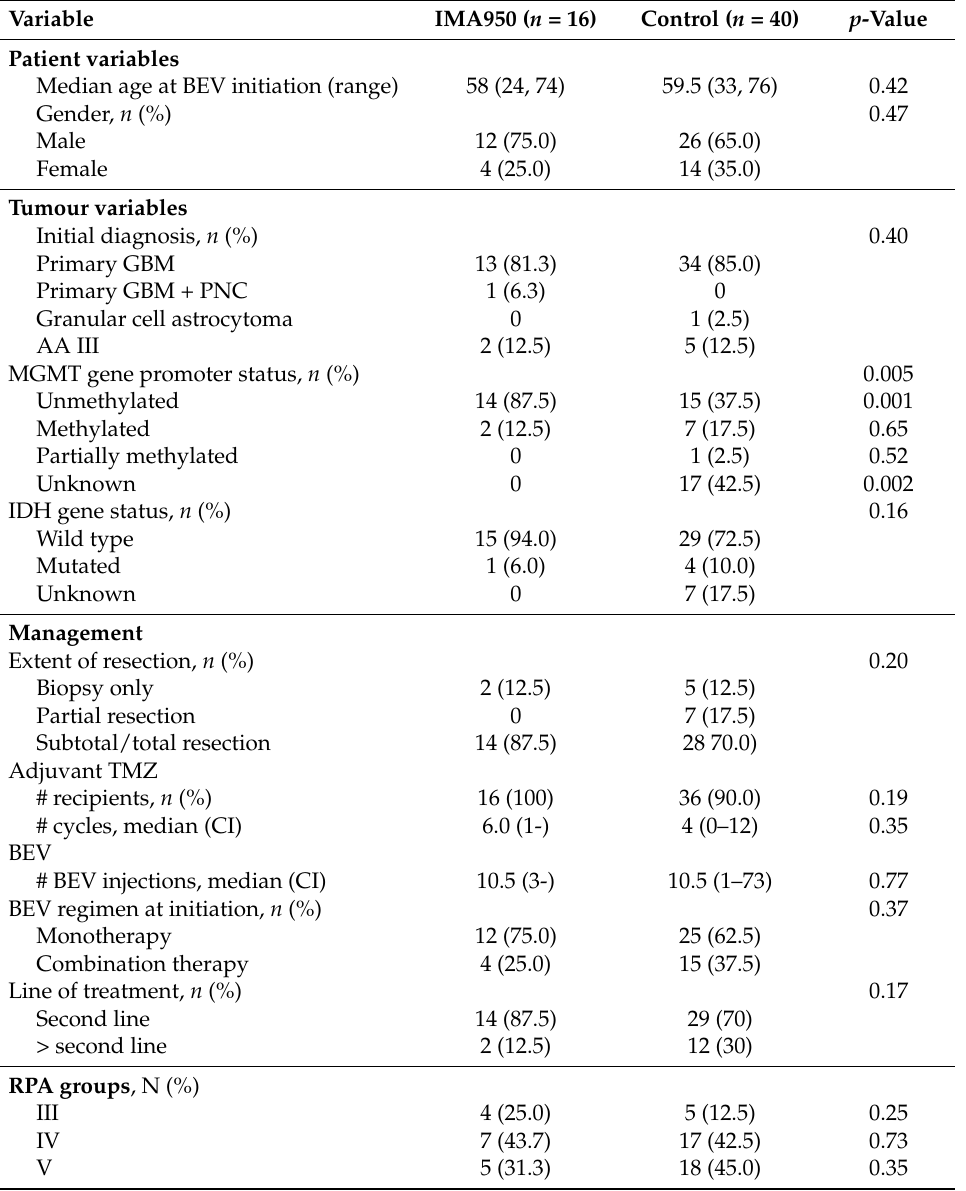
Table 1. Baseline patient